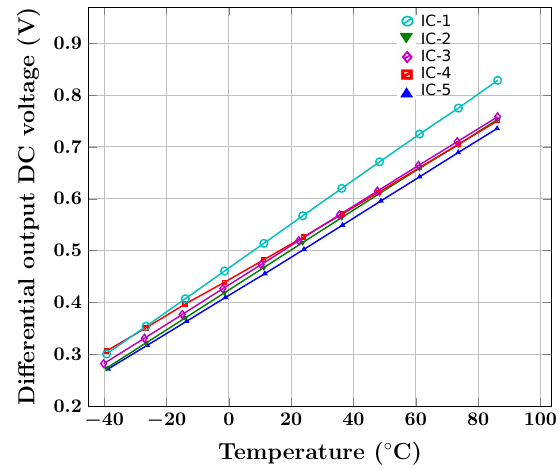
Figure 9. Differential voltage obtained from temperature sensing cores.